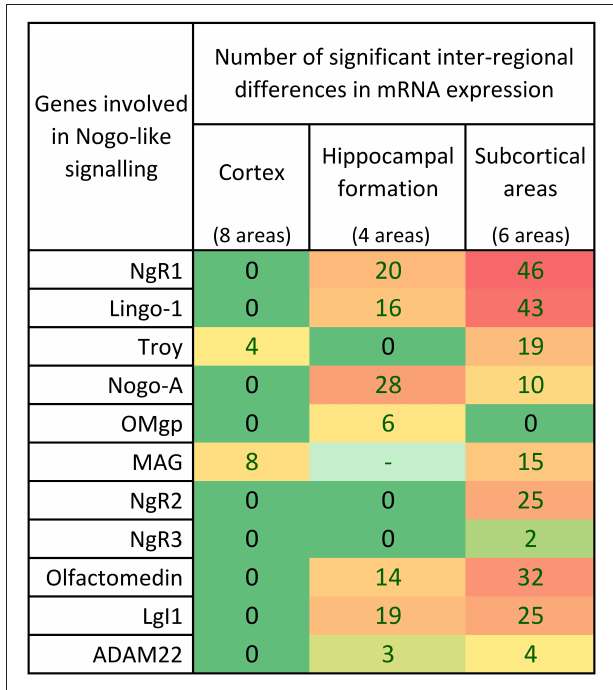
FIGURE 7 | Distribution of 339 significant differences ( p < 0.05) between regions for the 11 studied Nogo-related genes in cortex, hippocampal formation and subcortical areas. In the cortex, most of the genes had similar expression in most cortical areas investigated. In the hippocampus, 7/10 genes were differently expressed in the different regions while 3 had an even expression. Inter-regional mRNA expression level differences were foremost found in the heteregenous subcortical